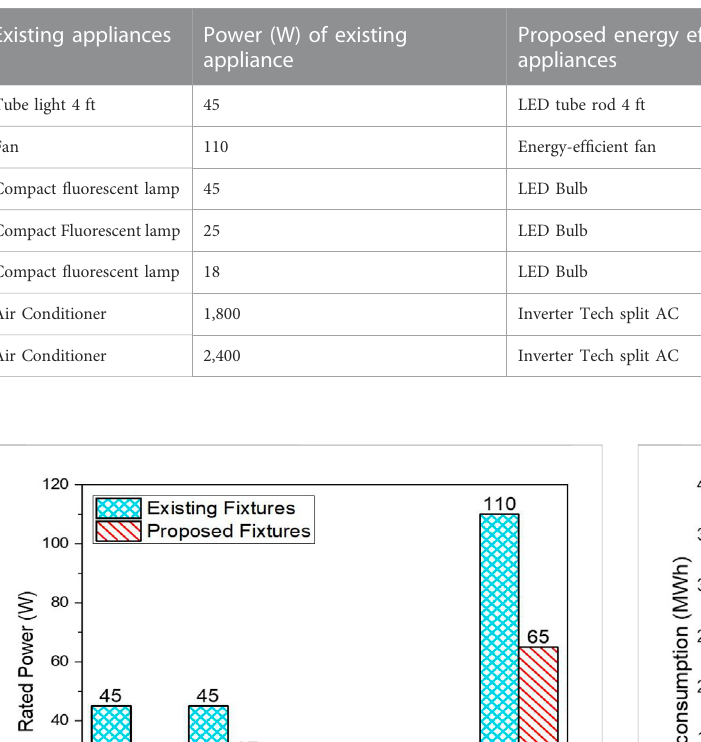
TABLE 3 Details of the existing and proposed fi xtures.